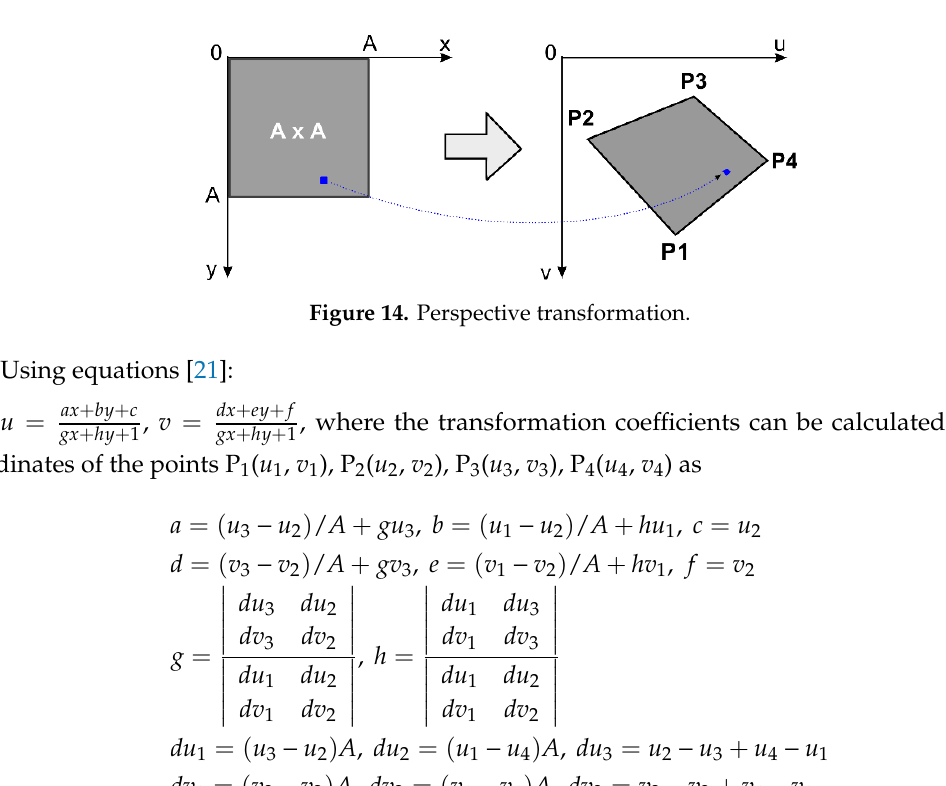
12 of 17 Figure 13. Perspective distortion: ( a ) initial estimate of the point P